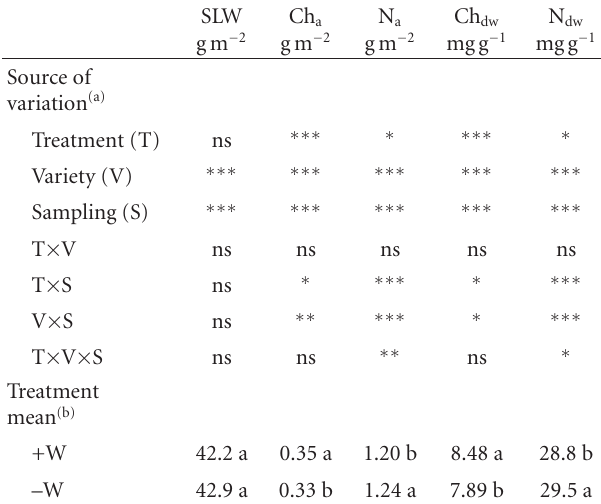
Table 3: Analysis of variance for the e ff ect of water treatment, variety, and sampling date on specific leaf weight (SLW) and on leaf chlorophyll and N concentration (Ch a and N a : area based; Ch dw and N dw : dry weight based). Included are mean treatment values across varieties and sampling dates for the two water treatments ( ±